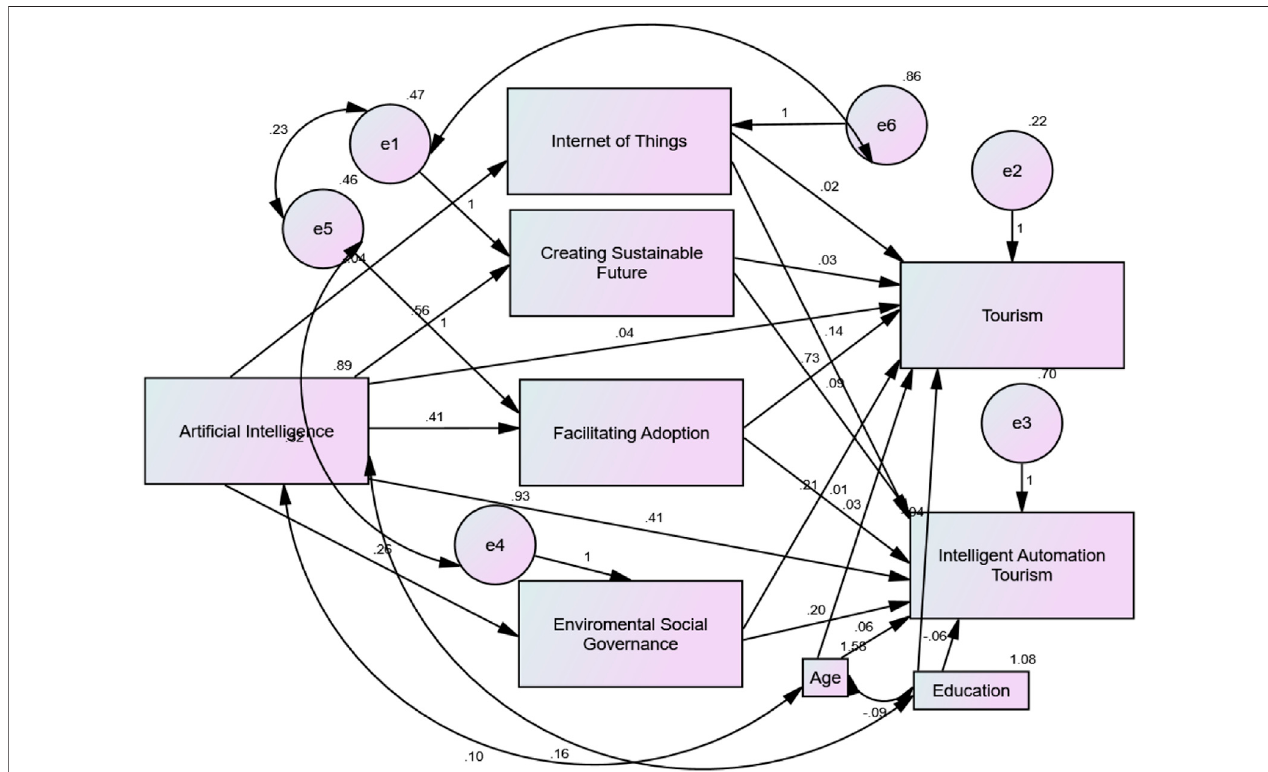
FIGURE 5 | Empirical results from a complex multivariate model representation standardized regression coef fi cient for intelligent automation in tourism among tourists ( N = 402). Note: a complex multivariate model of fi ve endogenous constructs and two exogenous indicators along with two control variables. Completely standardized maximum likelihood parameter estimate for the arti fi cial intelligent automation in tourism among tourists and employees.